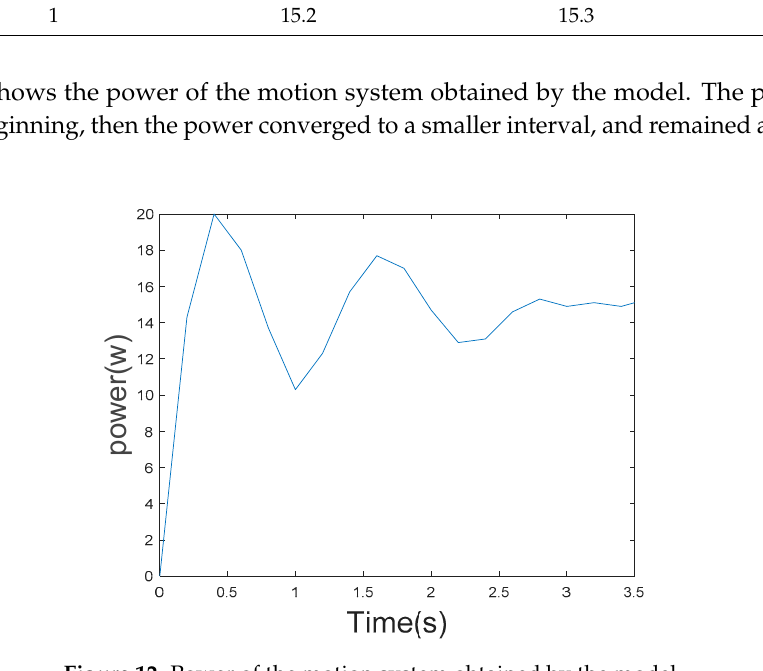
Table 4. Motion electrical power.